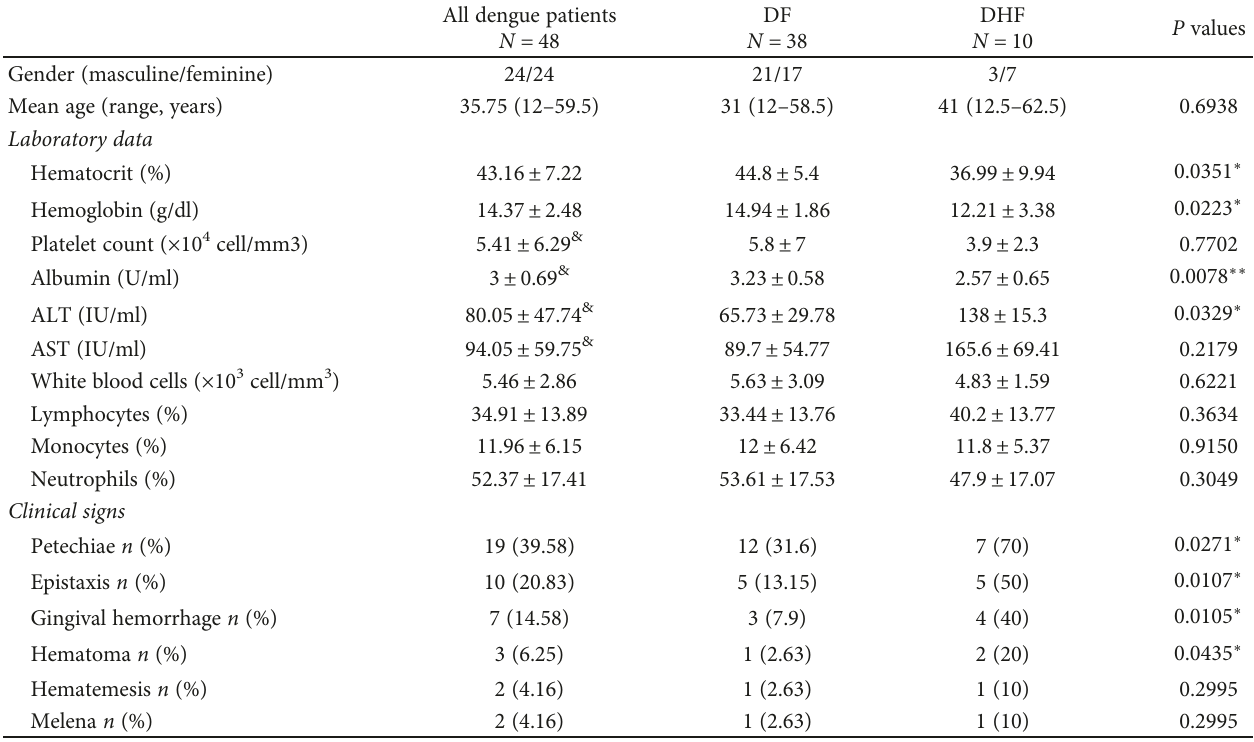
Table 1: Clinical characteristics of dengue patients during the outbreak of Puebla